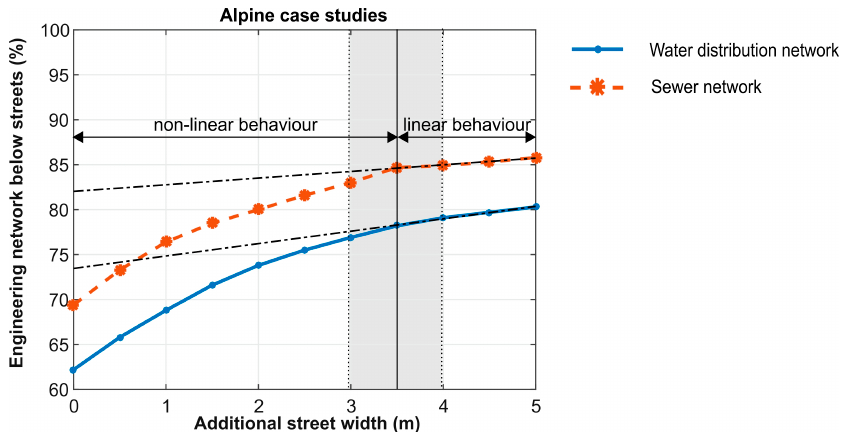
Figure 4. Sensitivity analysis of additional street width and covered network length below the streets for three alpine case studies.